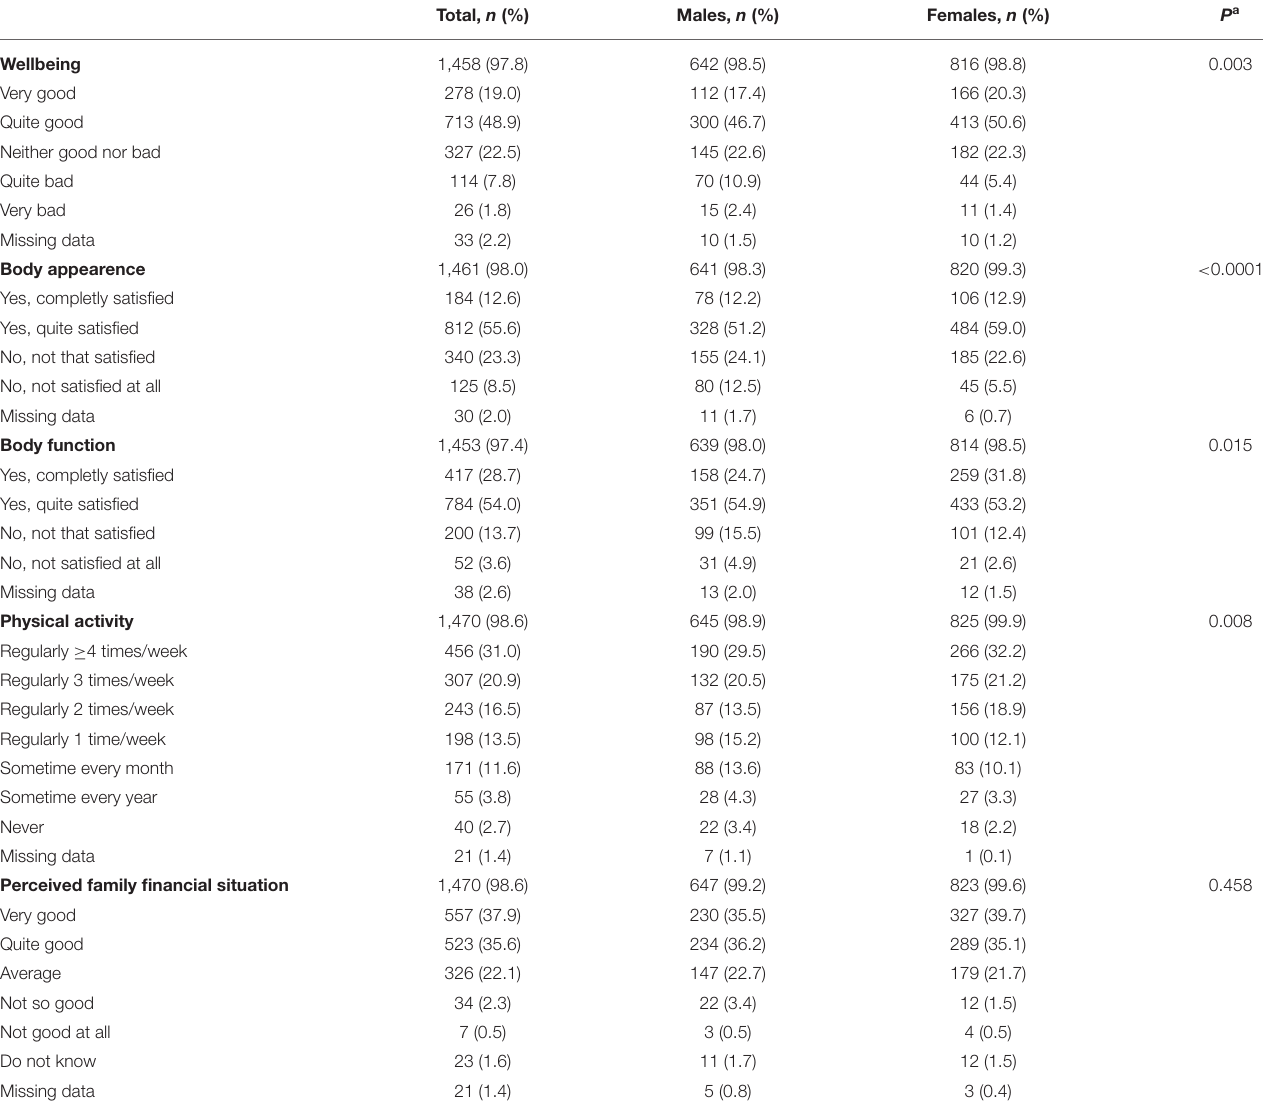
TABLE 2 | Description of wellbeing, body appearance, body function, physical activity, and family financial situation in male and female adolescents ( n = 1,491). Total, n (%) Males, n (%) Females, n (%) P